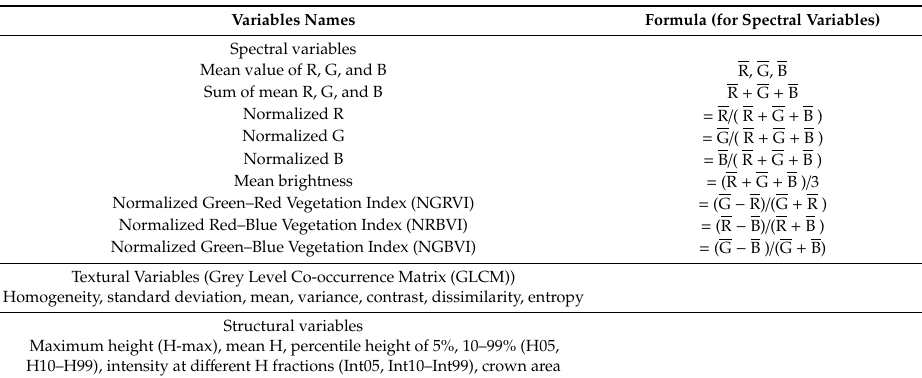
Table 4. Spectral, textural, and structural variables extracted from each tree crown polygon. Variables